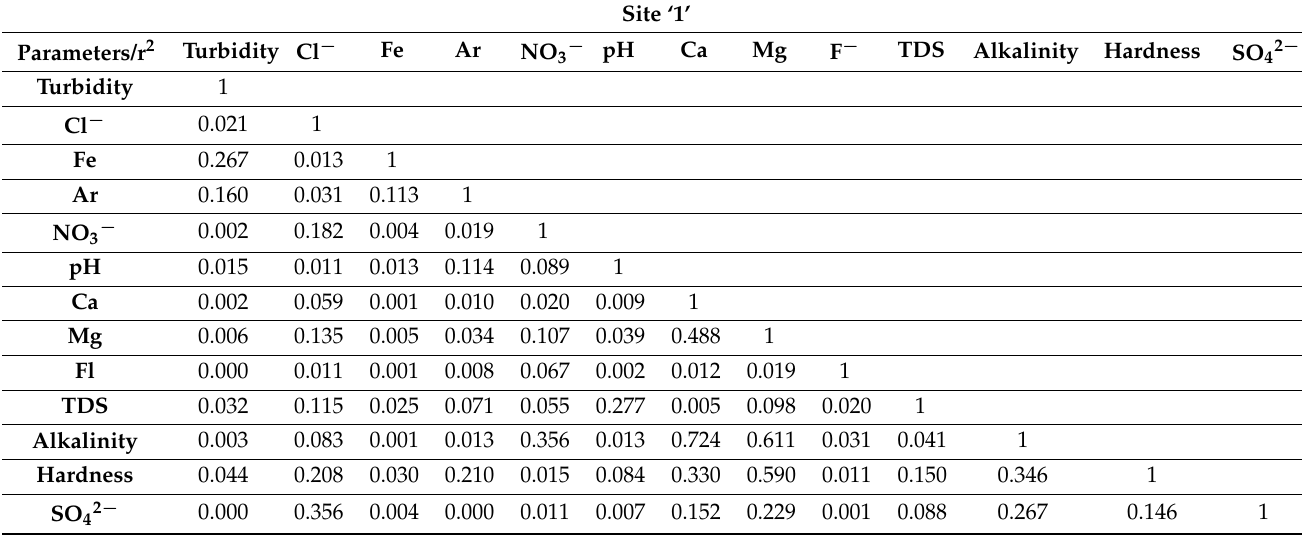
Table 3. Correlation matrix for water quality parameters over different sites